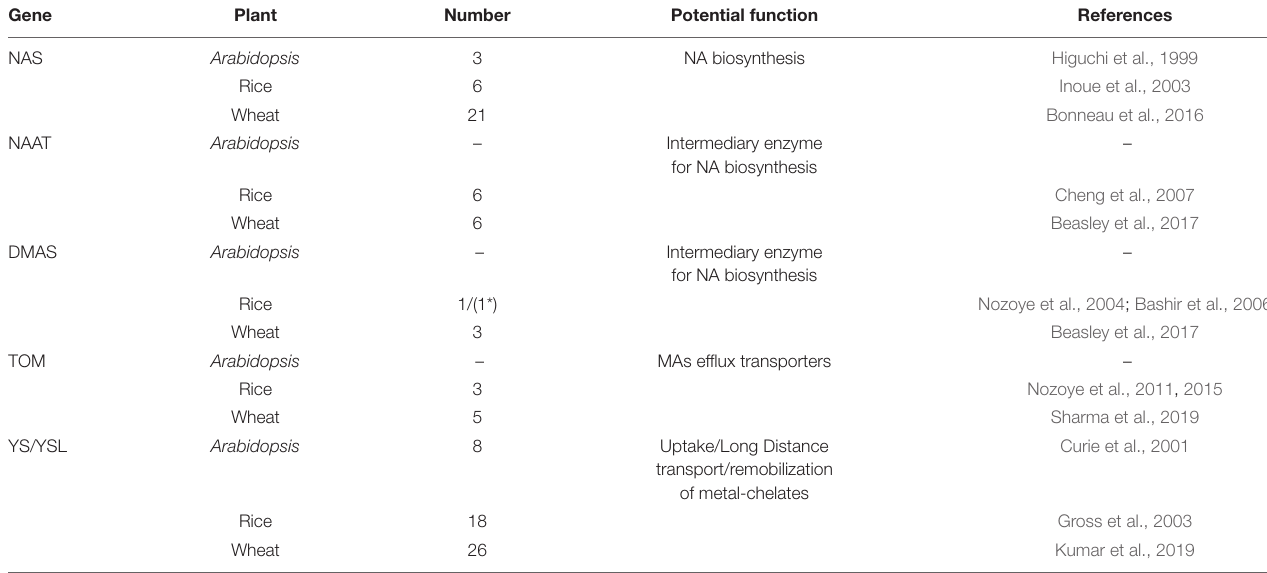
TABLE 1 | Putative orthologs/homologs and their number of genes for the Fe uptake reported from Arabidopsis , rice, and wheat.